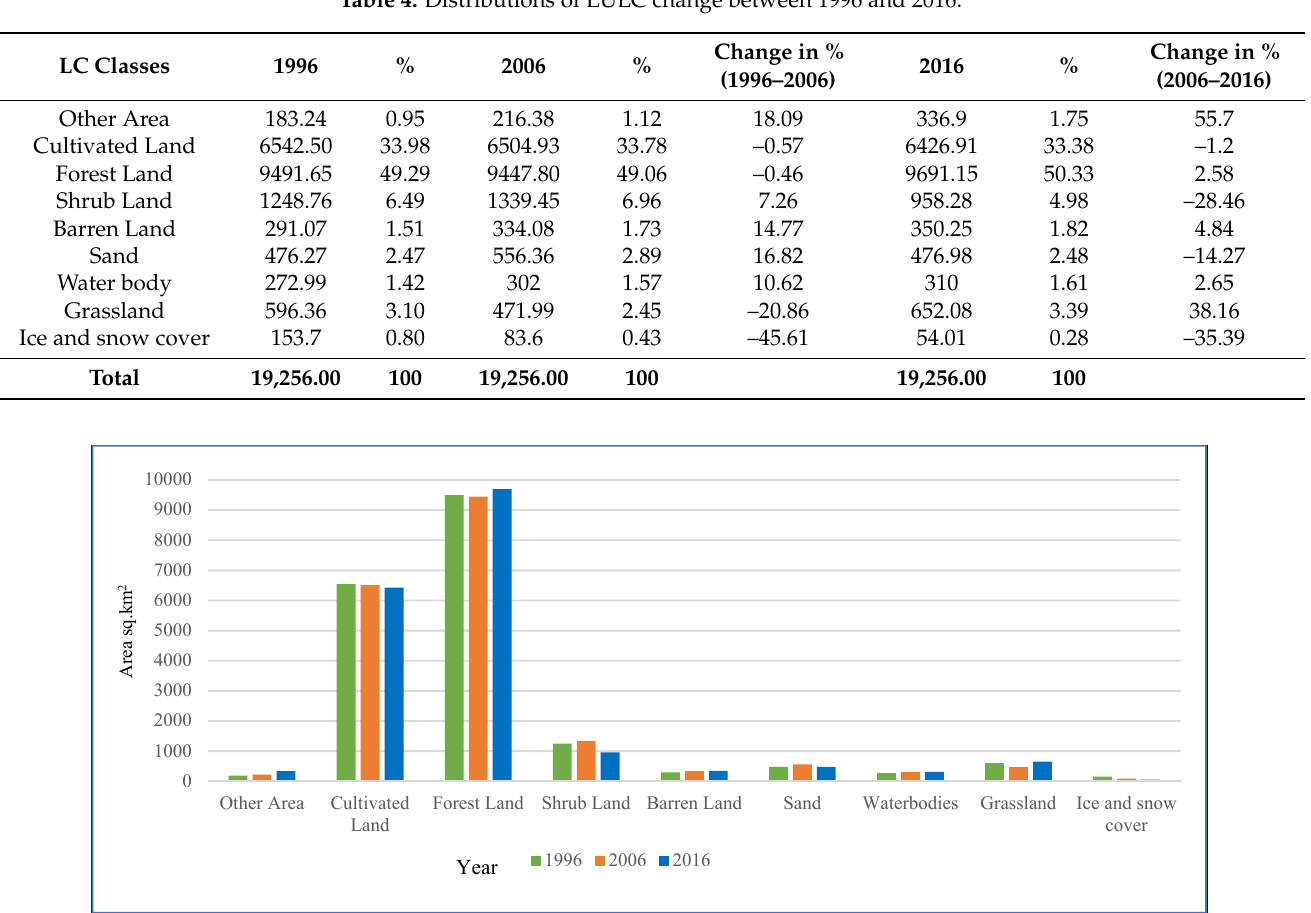
Figure 2. LC change trends in the study area, 1996–2016.